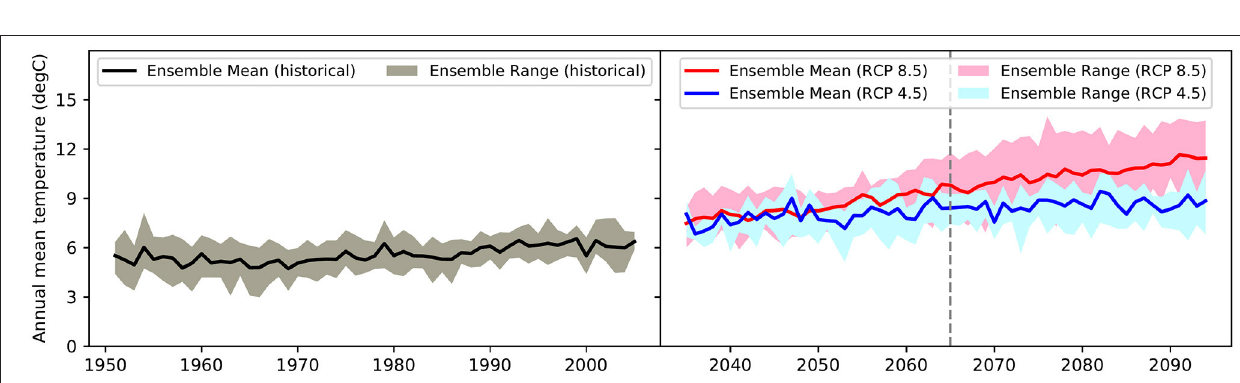
FIGURE 5 | Percentage change in monthly, seasonal, and annual over-land precipitation with respect to the baseline average precipitation for RCP4.5 and RCP8.5 scenarios in mid- and end-century periods.